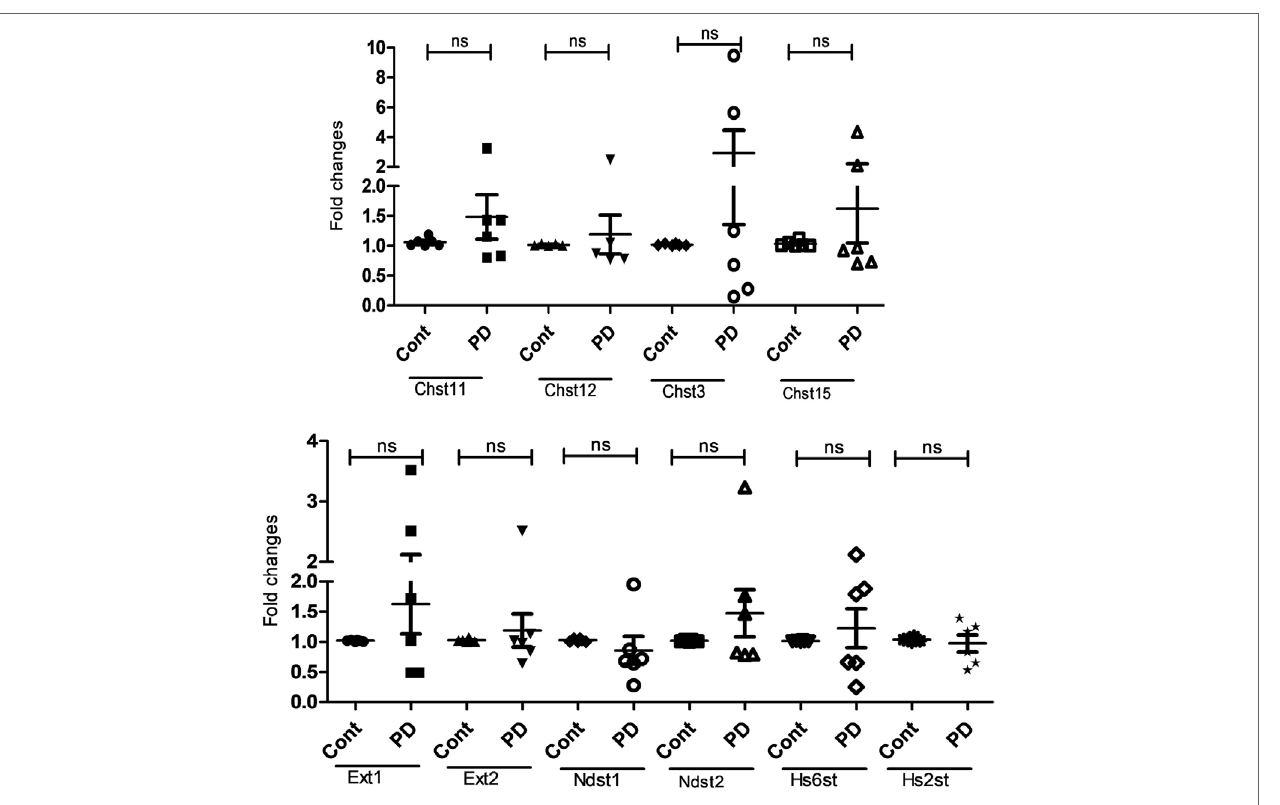
FigUre 8 | Upregulated expression of enzymes involved in chondroitin sulfate and heparin/heparan sulfate (HS) synthesis depends on the presence of the serglycin core protein. Bone marrow-derived mast cells (0.5–1.0 × 10 6 cells/ml) were generated from serglycin − / − mice and were incubated for 7 days with PD98059 (PD) (50 µM). Total RNA was then prepared and analyzed by qPCR for the expression of Chst11, Chst12, Chst3, Chst15, Ext1, Ext2, Ndst1, Ndst2, Hs6st1, Hs2st, as indicated ( n ≥ 4; data were pooled from at least four biological replicate experiments). Abbreviation: ns, not